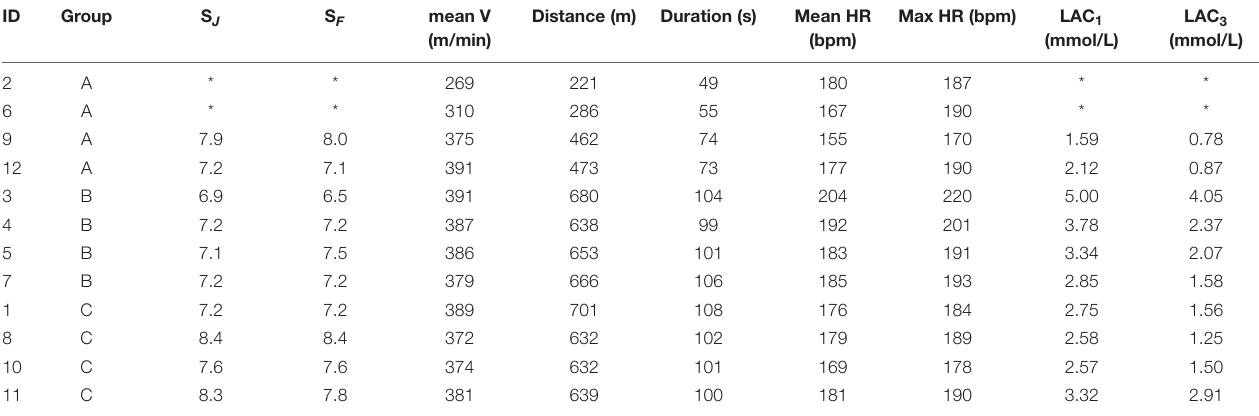
FIGURE 3 | Standardized grid exercise (SET grid ). Speed (blue) and heart rate (red) during the standardized grid exercise (SET grid ) are shown exemplary for one horse. The SET grid consisted of a warm-up phase followed by four rounds over a grid with five oxers with one canter stride in between each fence. The heights of the fences were increased each round with the highest height performed three times in a row without rest. The warm-up phase is not shown. The last three rounds through the grid are indicated by a gray background and the first jump of the grid is indicated by a dashed vertical line. TABLE 4 | Scores for jumping technique and resistance to fatigue, speed, distance, duration, mean and maximum heart rate, and post-exercise blood lactate concentration in response to the standardized show-jumping course (SET course